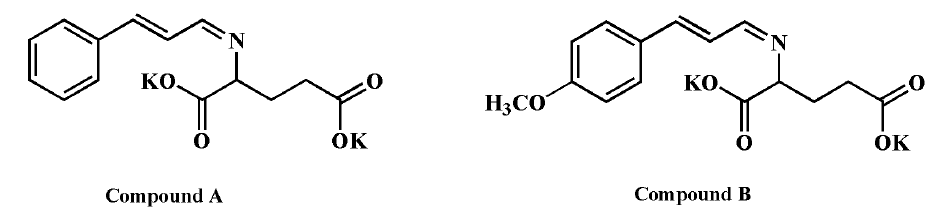
Figure 3. Structures of designed compounds.